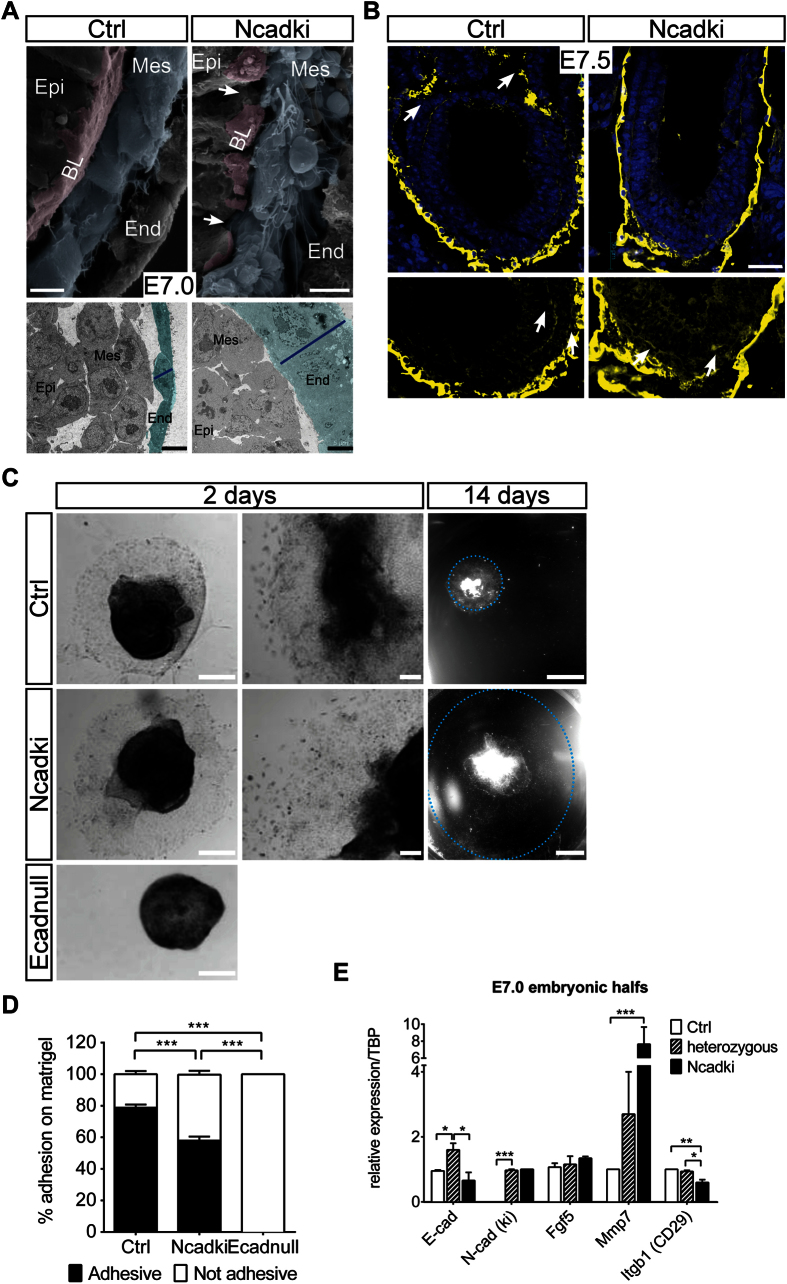
Tissue architecture and extracellular matrix components are changing upon ectopic cadherin switching.(A) Scanning electron microscopy shows loss of the smooth surface and attached basal lamina at mutant ectodermal cells (purple layer, arrows) as well as malformed mesoderm cells (blue) compared to controls. An expansion of the radial dimension of the VE cells (green) is seen in the mutant e.g. at the primitive streak region with transmission electron microscopy (lower panel) at E7.0 (blue line). Epi, epiblast; Mes, mesoderm; End, endoderm; BL, basal lamina. Scale bars represent 5 μm. (B) Anti-Laminin staining (yellow) and counterstaining of nuclei with DAPI (blue) reveals a loss of Laminin in the extraembryonic part at the region of the amnion in E7.5 Ncadki embryos that is found in control embryos (arrows in upper panel). No difference is detected in the gradual reduction in Laminin distribution in the embryonic part from proximal to distal, as well as in the reduction of Laminin between ectoderm and mesoderm at the side of the primitive streak in mutants and controls (arrows in lower panel). Scale bar represents 50 μm. (C) Functional analysis of the ECM of Ncadki embryos by plating explants of embryonic halfs to matrigel. Ecadnull embryos fail to attach and spread, whereas Ncadki (4/7) and control embryos (34/42) succeed. Explants of Ncadki spread much faster and cover the whole plate within 14 days (dashed line). Scale bars represent 250 μm for left, 100 μm for middle and 500 μm for right panels. (D) Quantification of successful attachment to the plates of embryonic explants of indicated genotypes. (E) qRT-PCR analysis of EcadNcad/ΔEpi;Sox2Cre (Ncadki), EcadNcad/+;Sox2Cre (heterozygous) and Ecad+/ΔEpi;Sox2Cre (Ctrl) embryonic halfs, showing a >7fold increase in Mmp7 and slight reduction of β1-Integrin (CD29) expression in Ncadki. The specimen preparation does not exclusively contain epiblast cells and unrecombined VE cells are included in the RNA isolation. Accordingly, effects are likely to be less pronounced as indicated by incomplete reduction in E-cad levels.